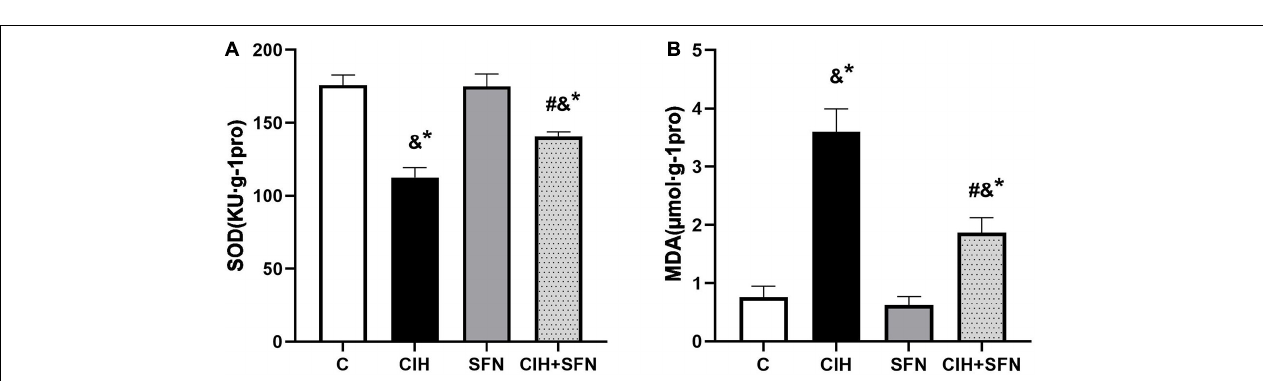
FIGURE 3 | SFN resists CIH-induced oxidative stress in hippocampus of mice. Effects of SFN treatment on hippocampal tissue lysates SOD (A) and MDA (B) levels in the mice subjected to CIH exposure. Data were represented as the means ± SD, n = 5. * p < 0.01 vs. C; # p < 0.01 vs. CIH; & p ≤ 0.01 vs. SFN.